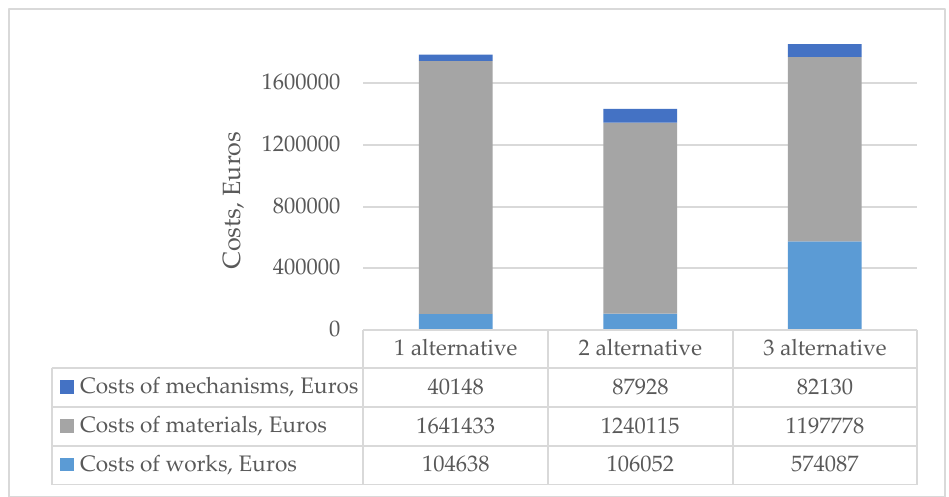
Figure 10. Comparison of costs of installing the building frame.